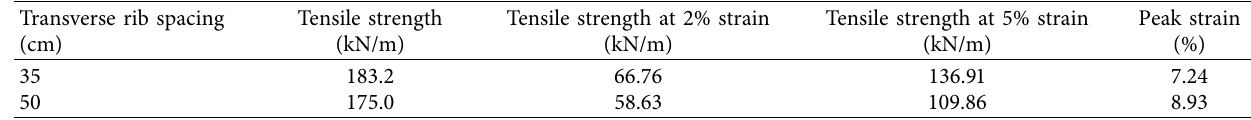
Figure 1: Uniaxial Table 1: The technical indexes of geogrid.